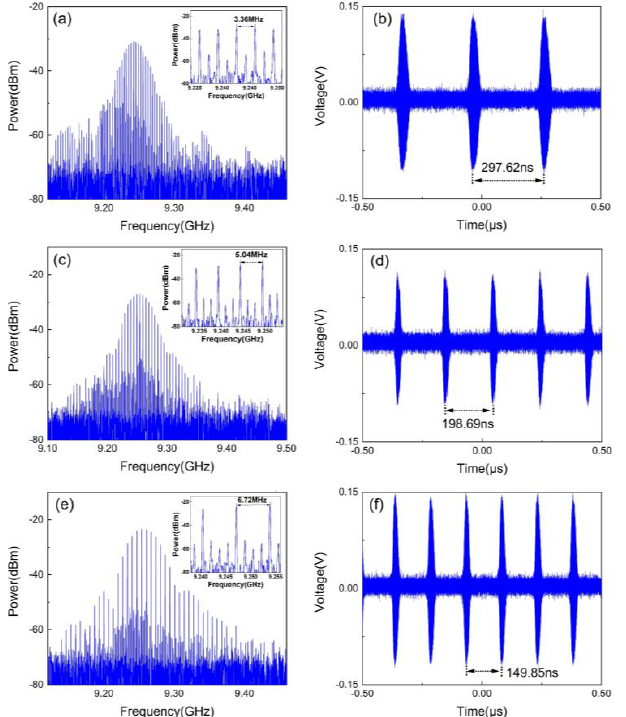
Figure 7. Generated microwave pulses with harmonic mode-locking: ( a , c ,e) frequency spectra, ( b , d , f ) temporal